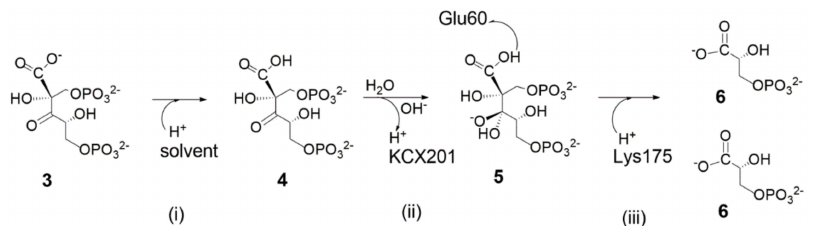
Figure 12. Mechanism for the steps following C2-carboxylate formation: ( i ) C2-carboxylic acid is formed by protonation from an unknown donor via solvent channels; ( ii ) C3-gemdiolate is formed as H 2 O approaches C3 and undergoes proton abstraction by KCX201; ( iii ) C2-C3 bond scission of the C3-gemdiolate, concerted with stereospecific C2-protonation by LYS175 and deprotonation of the C2-carboxylic acid by GLU60, yields product. (Figure 12 from ref. [41], adapted and used by